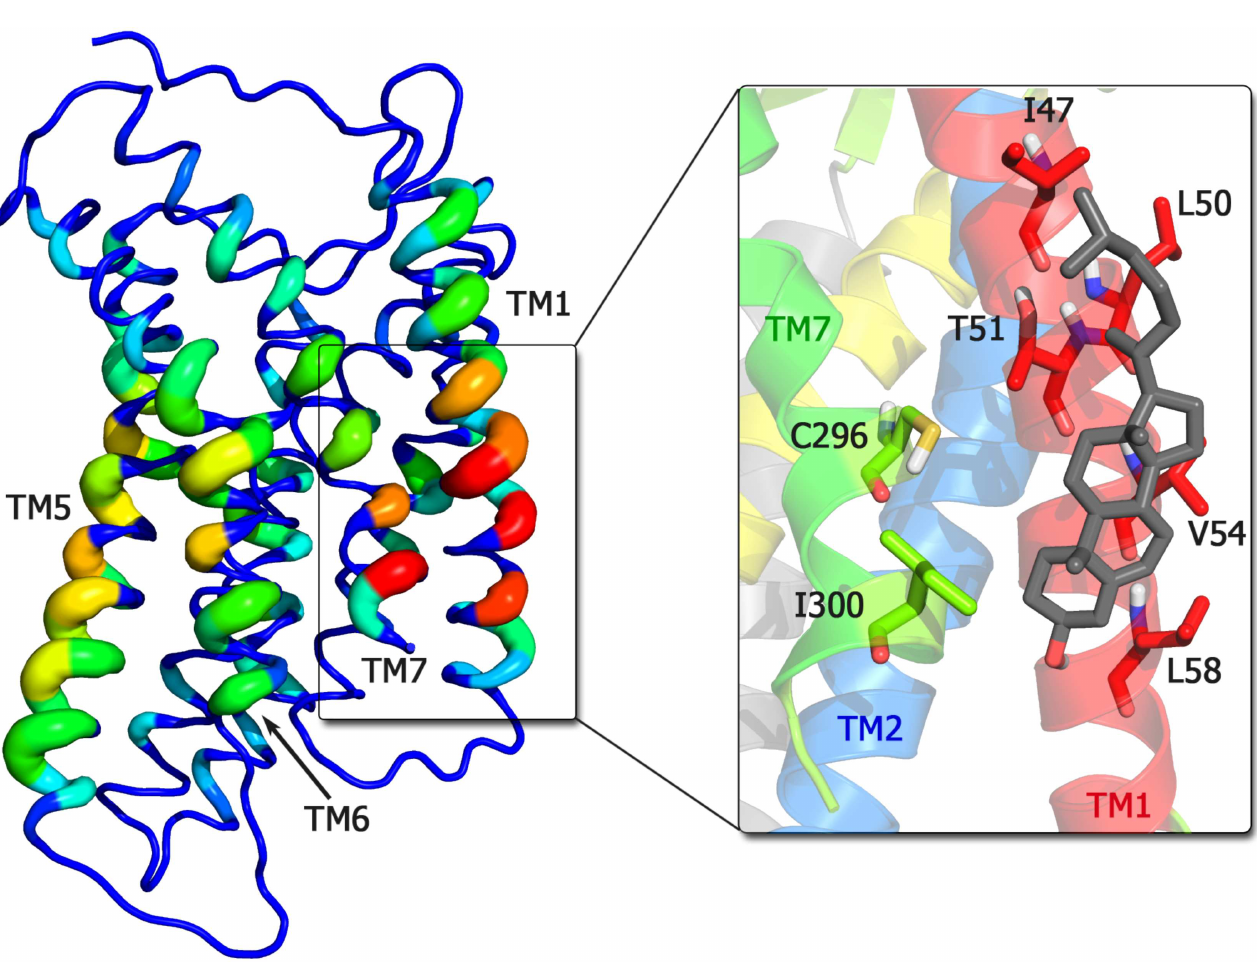
Fig 4. Cholesterol occupation hotspots on CXCR4. Cholesterol bindingoccupancy in simulations of CXCR4 dimerization at 10% cholesterol concentration. The color and thickness coded residue-resolved occupancy scale ranges from 0 to 65% time occupancy (red, thick). The inset shows a detailed view on the main cholesterol bindingsite at the TM1,7 interface with the main involvedresidues in stick representation. Additionally, a bound cholesterol moleculeis depicted